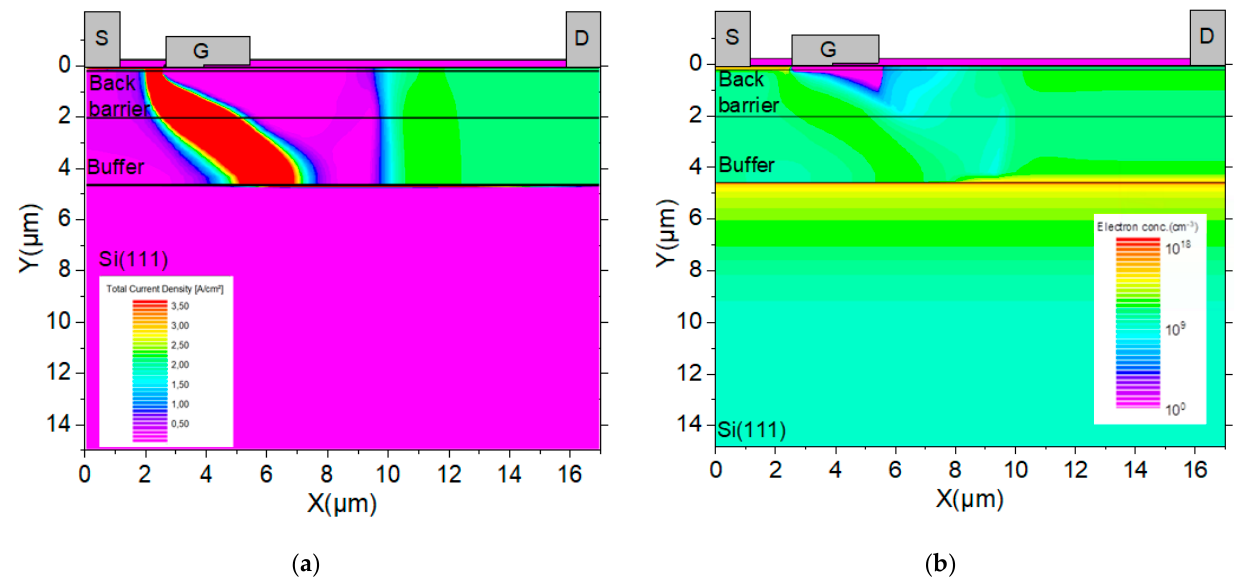
Figure 7. MOS-HEMT structure cross section of ( a ) current density and ( b ) electrons concentration at V BD showing the current path from the drain to the source electrode and the 2DEG at AlN/Si interface. The bias voltage at the drain contributes to the accumulation of electrons drain side.